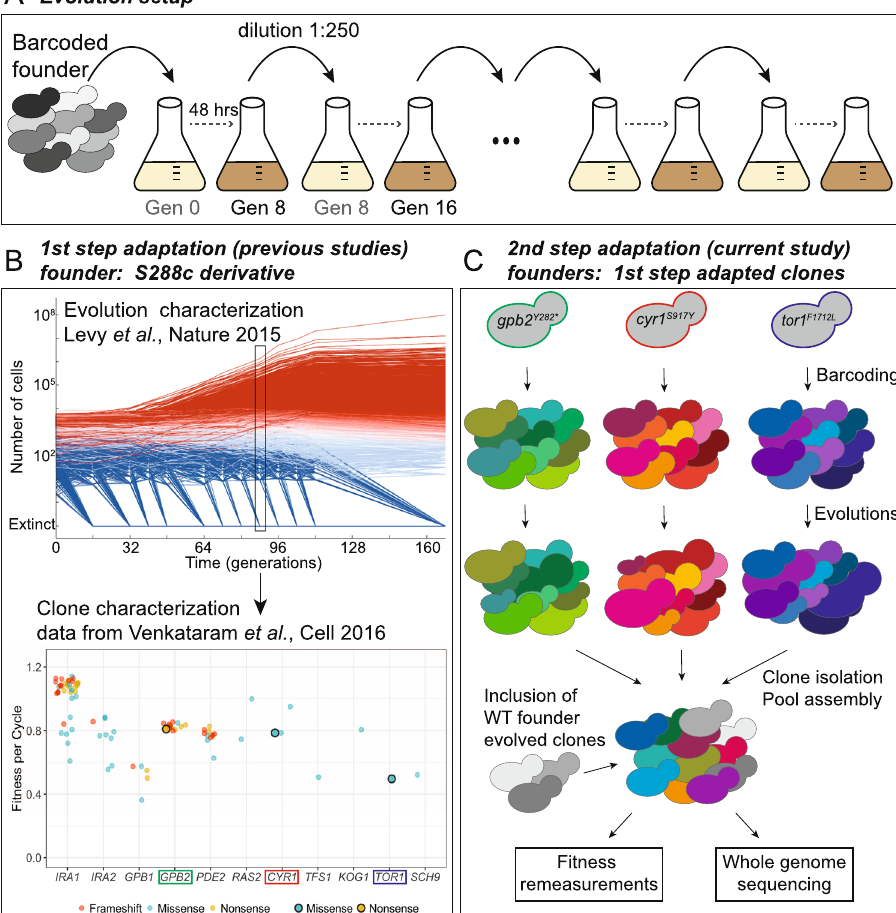
Fig. 1 Experimental design. A All evolutions were performed under identical conditions, including transfer and environmental conditions. B The founders used in this study derived from adaptive clones isolated and characterized previously 4,44 . The upper graph of ( B ) has been reproduced from ref. 44 . Red, cyan, and blue lines represent lineages with respectively diminishing probability of carrying an established bene fi cial mutation. The lower graph of ( B ) is a remake of Fig. 4 from ref. 4 . Different mutation types are color-coded as annotated. The ancestors of the evolutions of the current study are highlighted with an outer black circle. C Each founder carries a single adaptive mutation ( gpb2 Y282* , cyr1 S917Y , and tor1 F1712C ), and was barcoded and propagated for 20 transfers. The mutations gpb2 Y282* , cyr1 S917Y , and tor1 F1712C are color-coded green, red and blue, respectively. Different shades represent barcoded clonal derivatives. Gray represents the wild-type ancestor (annotated as WT). The same color scheme is used to annotate the ancestors or their evolved derivatives throughout the paper. Differences in yeast sizes represent barcode frequency changes. Adaptive clones are isolated and characterized via fi tness re-measurements and whole-genome